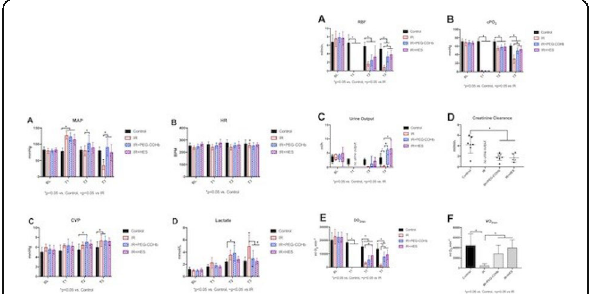
Fig. 1 (abstract 001209). See text for description